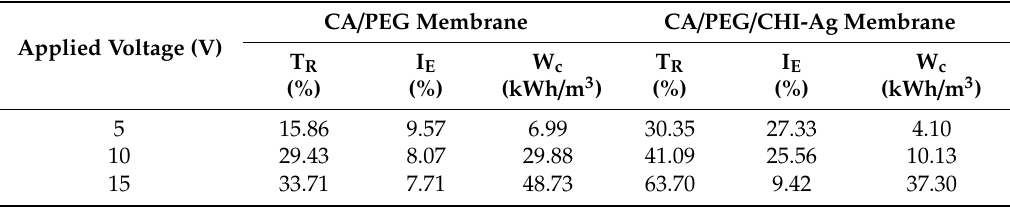
Table 5. The values of T R (%), I E (%) and W c (kWh / m 3 ) at di ff erent applied voltages, after 1 h of electrodialysis